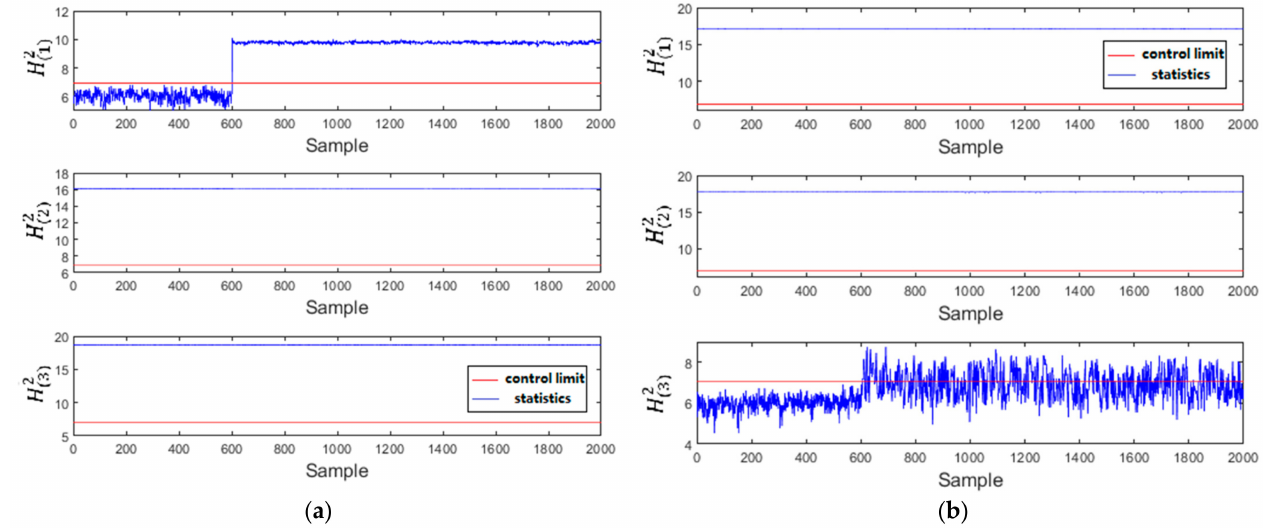
Figure 9. Monitoring charts of MDPC-PVAE in the TE process: ( a ) Fault 4 in Mode 1; ( b ) Fault 28 in Mode